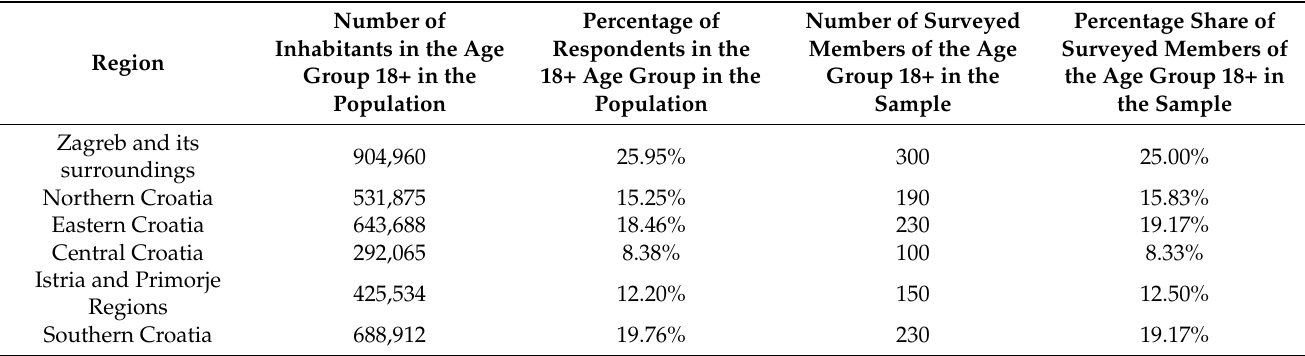
Table 2. Total number and percentage of adult citizens of the Republic of Croatia according to the 2011 census and the achieved sample within each